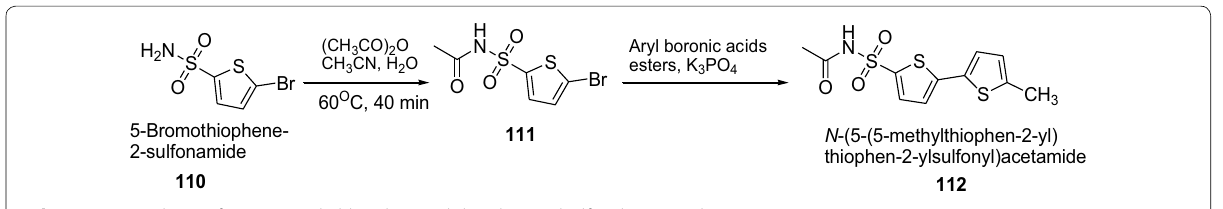
a p < 0.05: Statistically significant from the control using one way ANOVA (Two- sided Dunnett as Post Hoc test)